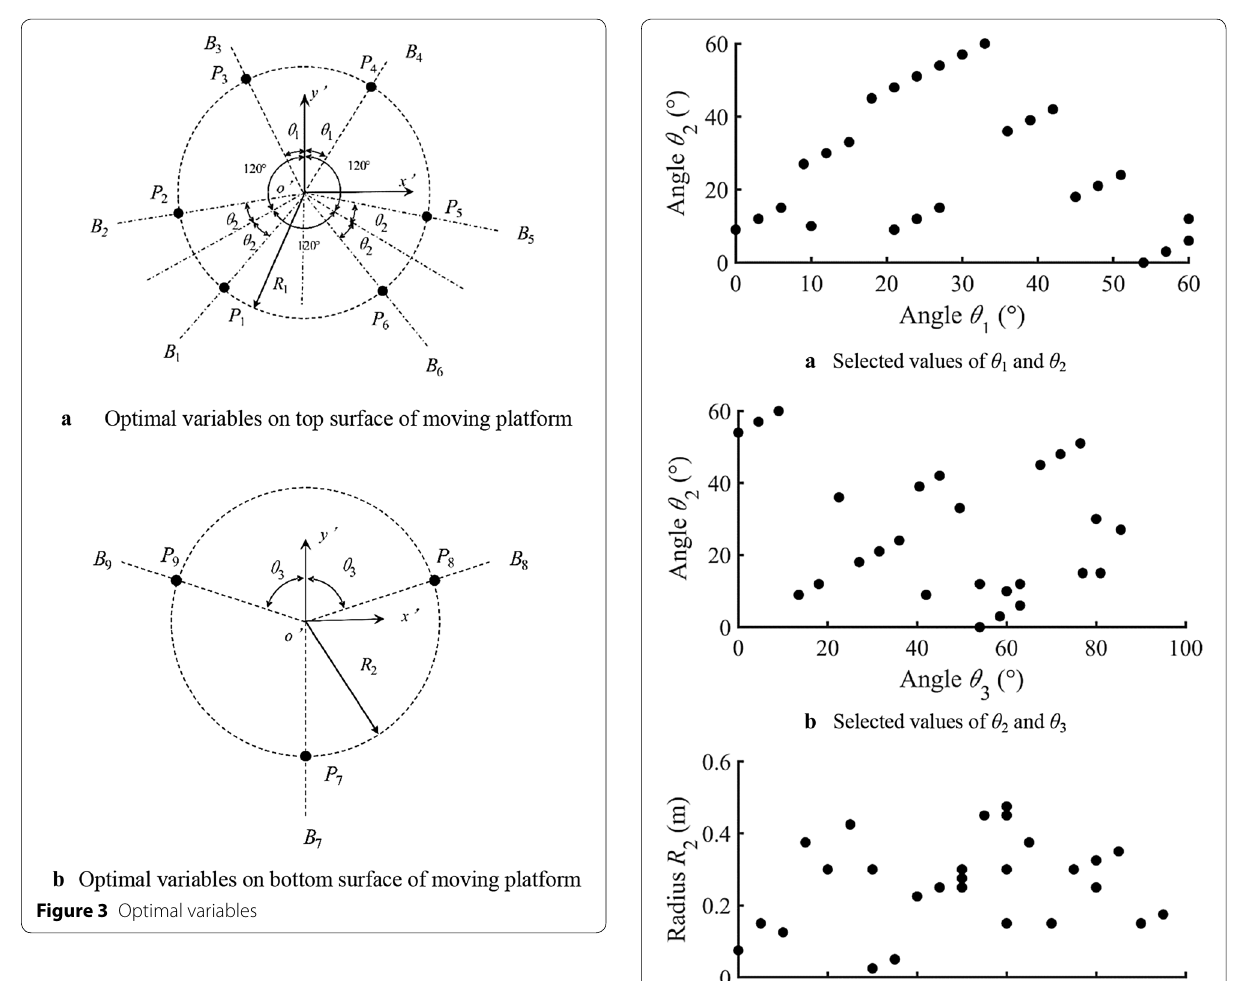
Table 1 Variable names and levels